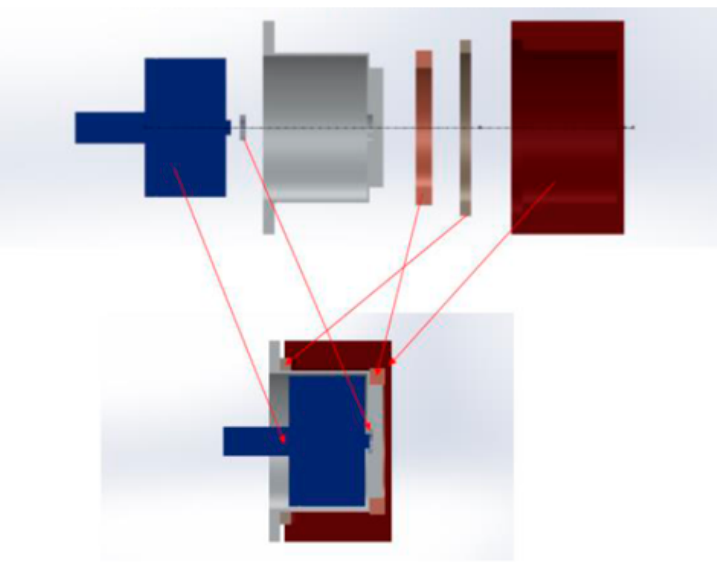
Figure 2. Two-dimensional (2D) view of the parts in the magnetic coupling.